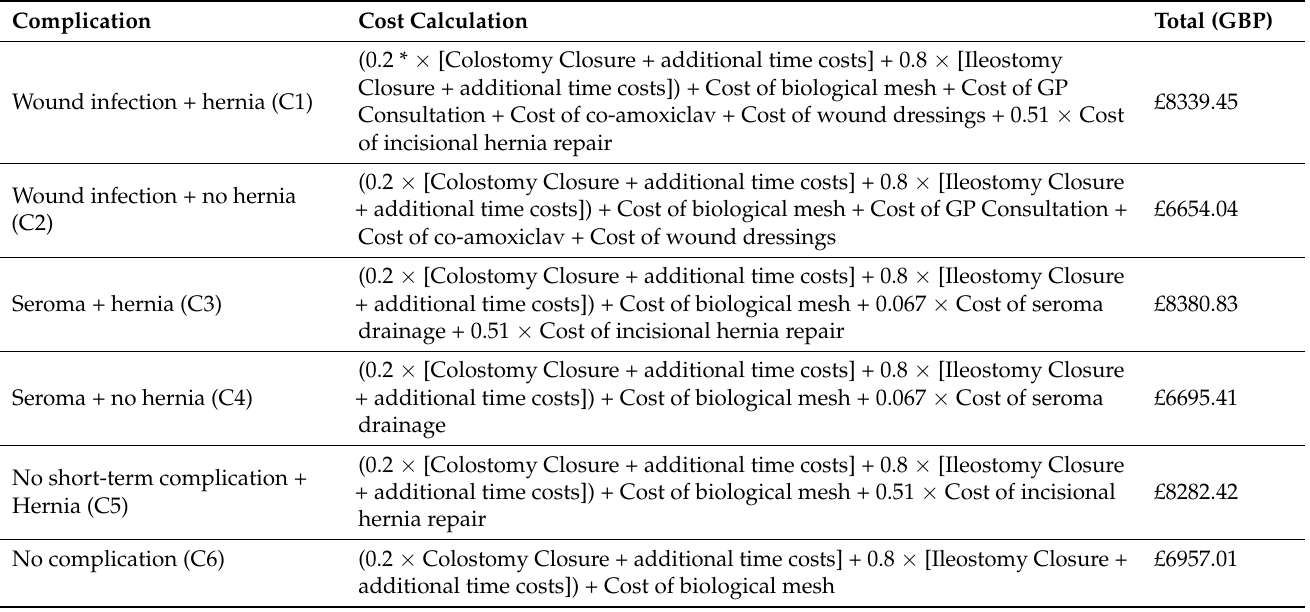
Table A3. Calculations conducted to obtain the total cost associated with each terminal node in the prophylactic biological mesh reinforcement arm of the decision tree *.